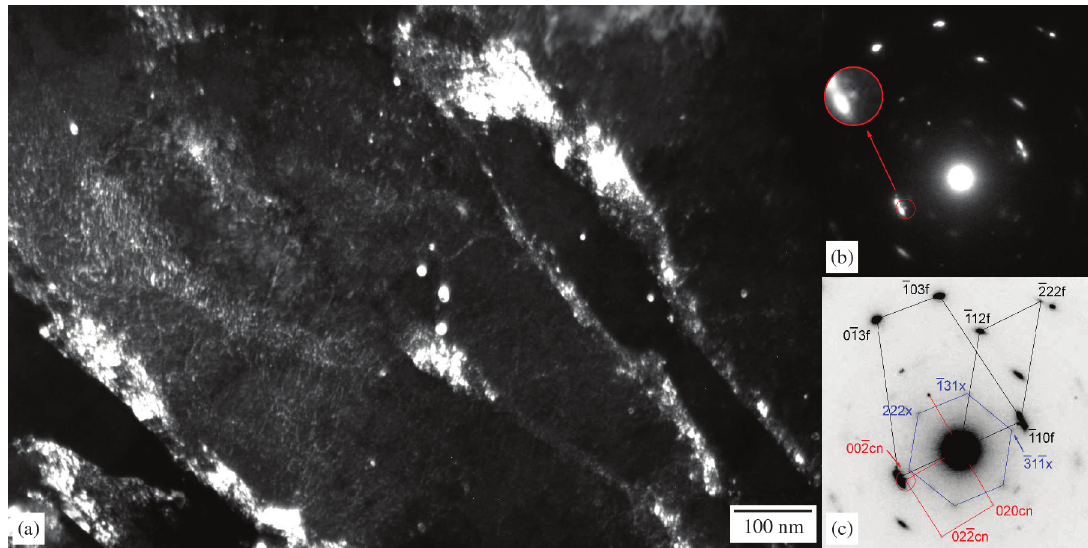
Figure 3. TEM micrograph showing in (a) dark field contrast taken from a {002}cn reflection of undissolved globular (Nb,Ti) carbonitrides and respective electron diffraction pattern in (b). Key diagram in (c) shows that particles were formed in austenite and also presents some magnetite (x) reflections.